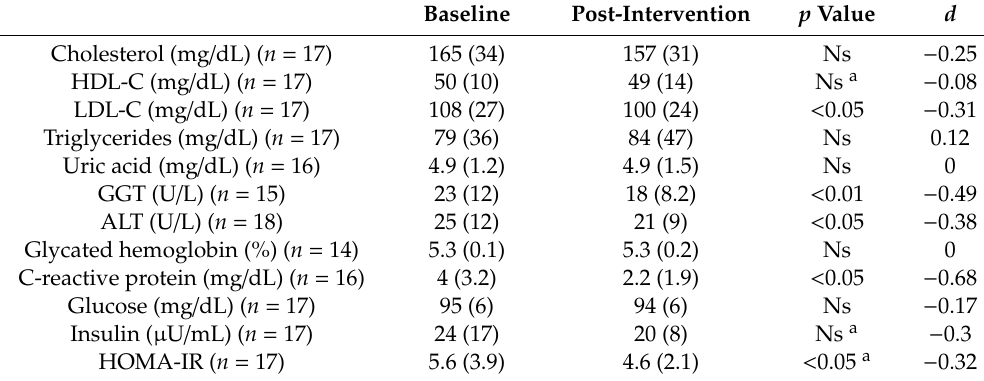
Table 3. Evolution of the biochemical parameters expressed as mean (SD). Baseline